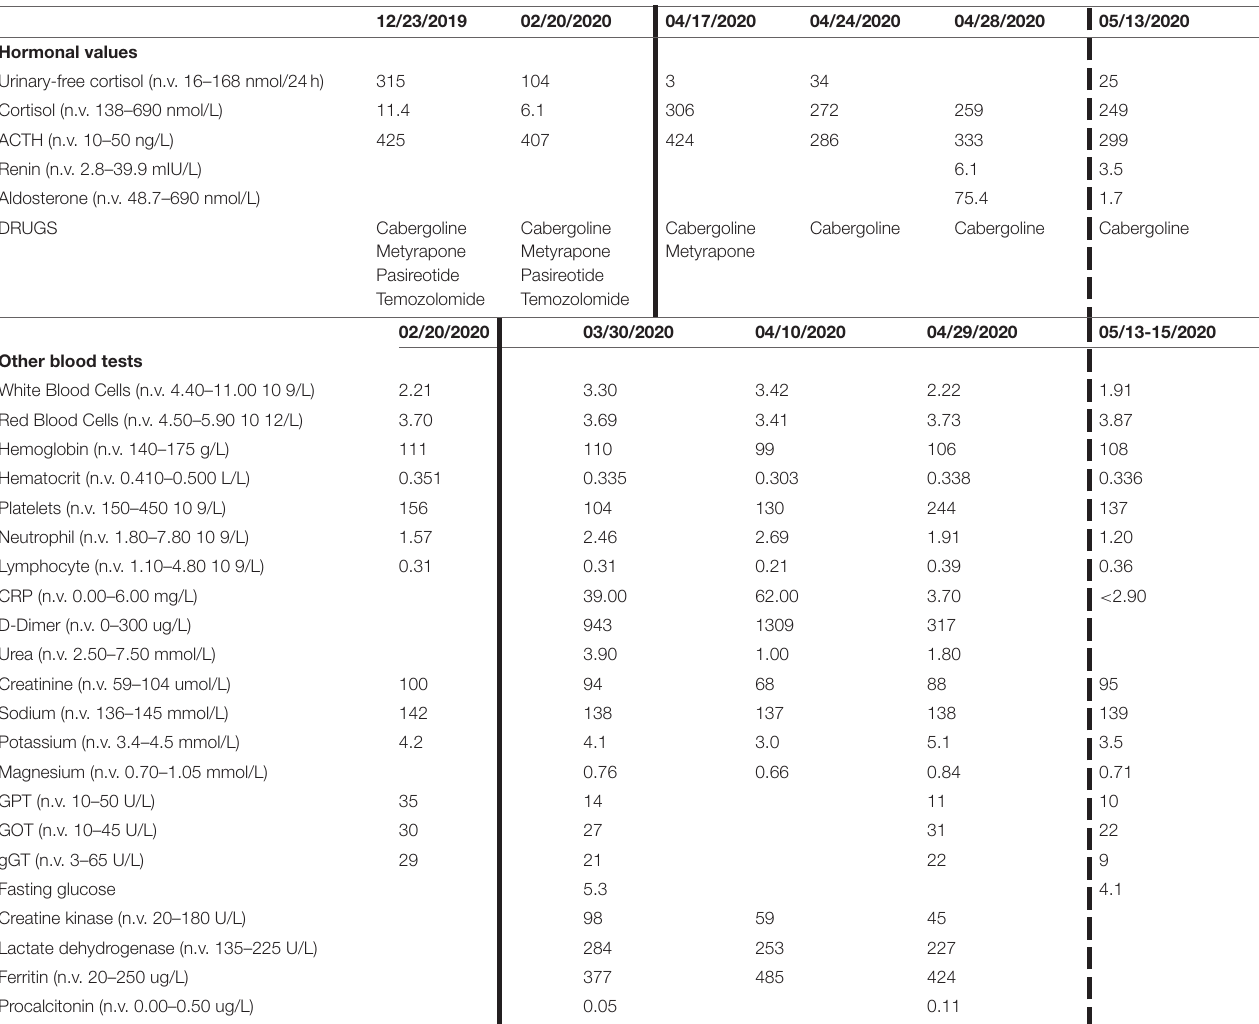
TABLE 1 | Blood tests